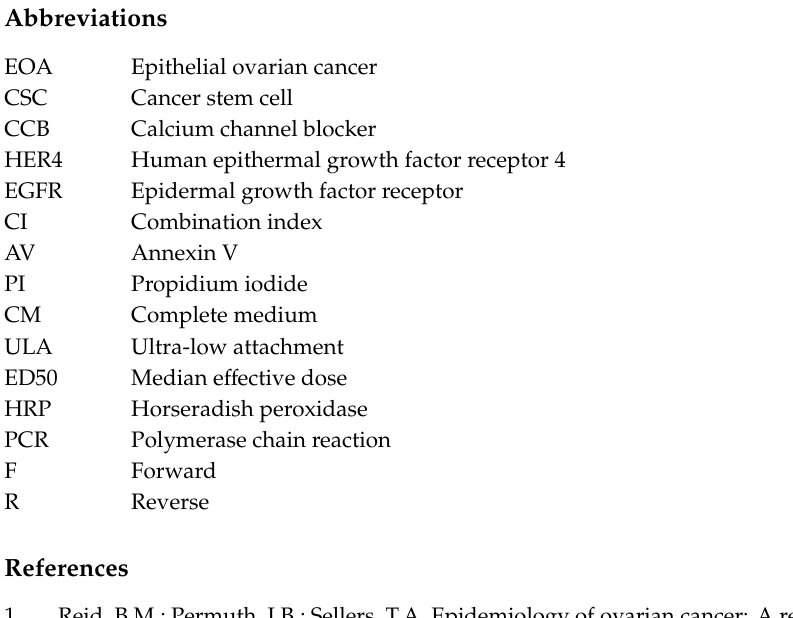
Figure S1. Expression of stemnessmarkers and EGFR family mRNA levels in SKOV3 and SKOV3-SP cells.